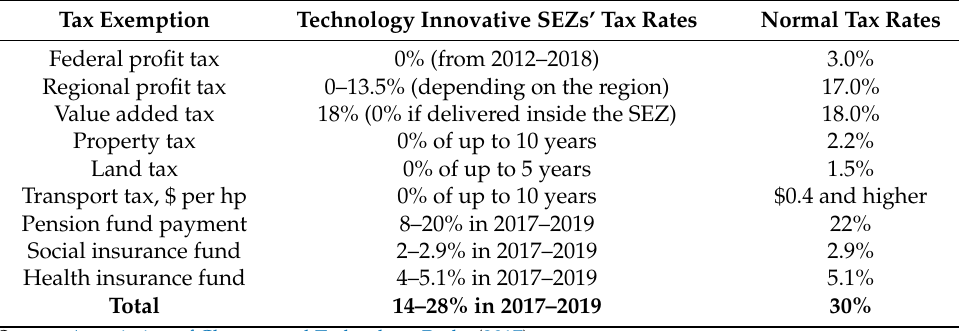
Table 2. Tax privileges of the SEZ clusters in